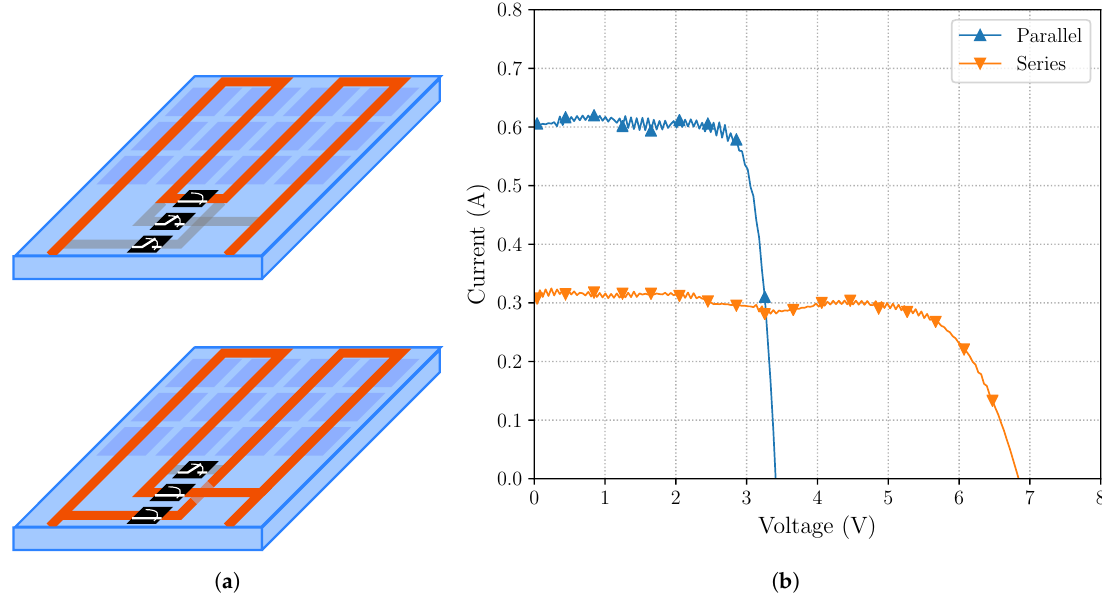
Figure 12. Setup and measurement result of a small-scale two-substring reconfigurable panel. The two substrings can be connected in either series or parallel. ( a ) Schematic representation of the test setup. ( b ) Measurements of the output voltage and